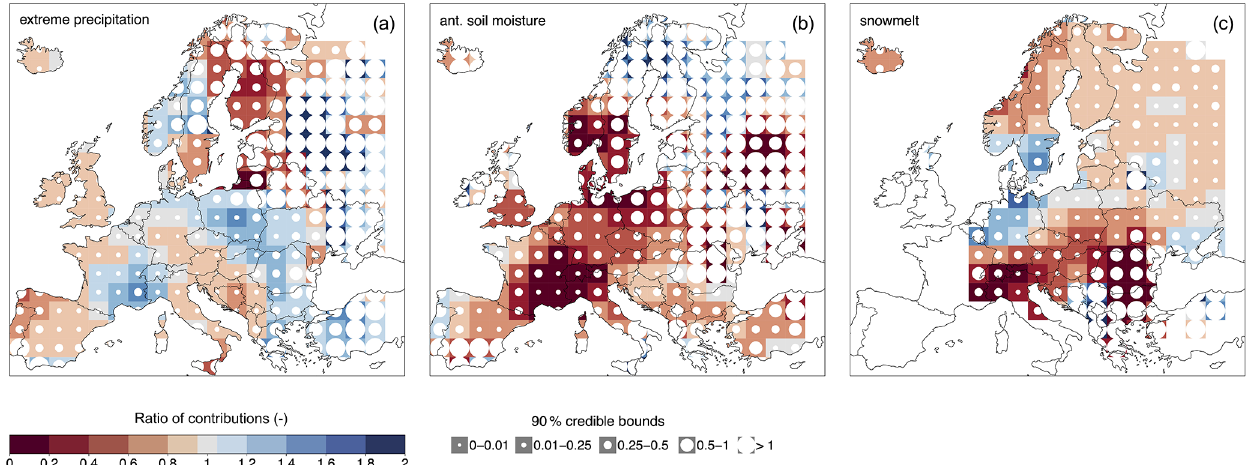
Figure 6. Same as Fig. 4 but for the ratios of the contributions of extreme precipitation (a) , antecedent soil moisture (b) and snowmelt (c) to changes in q 100 relative to q 2 . Values below 1 (red colour) indicate that the contribution of the driver to q 100 is smaller than the contribution to q 2 ; values above 1 (blue colour) indicate that the contribution of the driver to q 100 is larger than the contribution to q 2 .